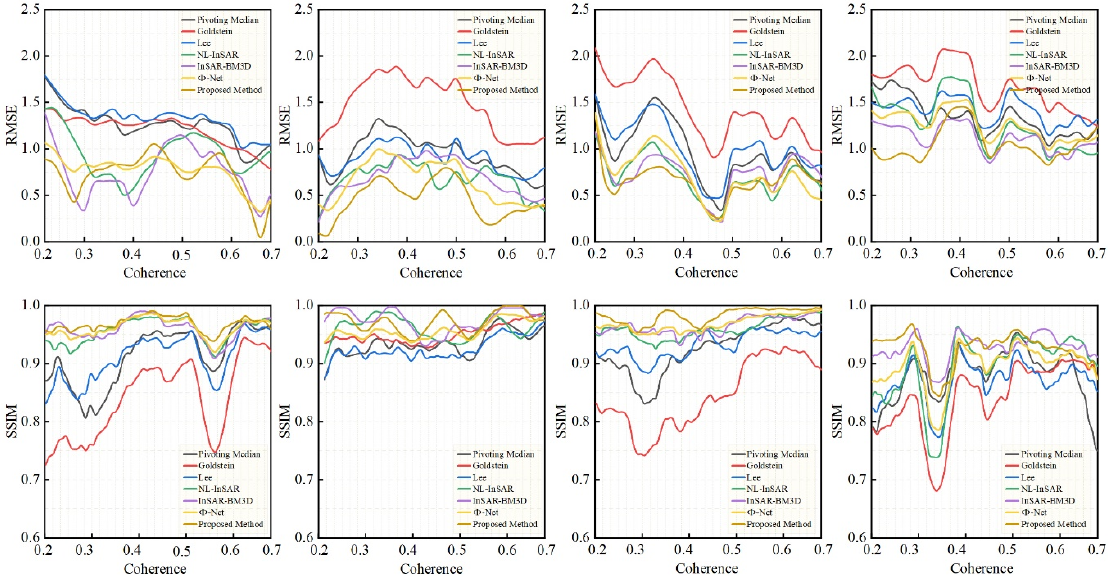
Figure 4. RMSE and SSIM variation curves for the four simulated interferograms (left to right): scenarios 1–4.